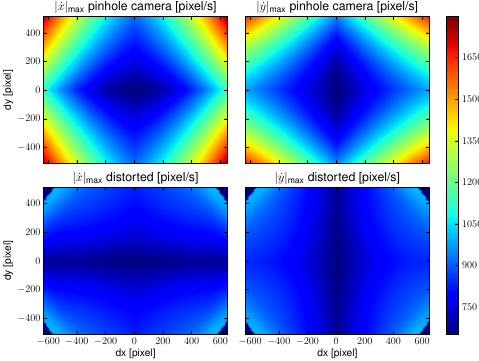
Figure 6: x and y pixel velocities under rotation of the camera (max. an- gular velocity) plotted against the pixel distance from the principal point. Results plotted for pinhole camera model (top) and distortion camera model